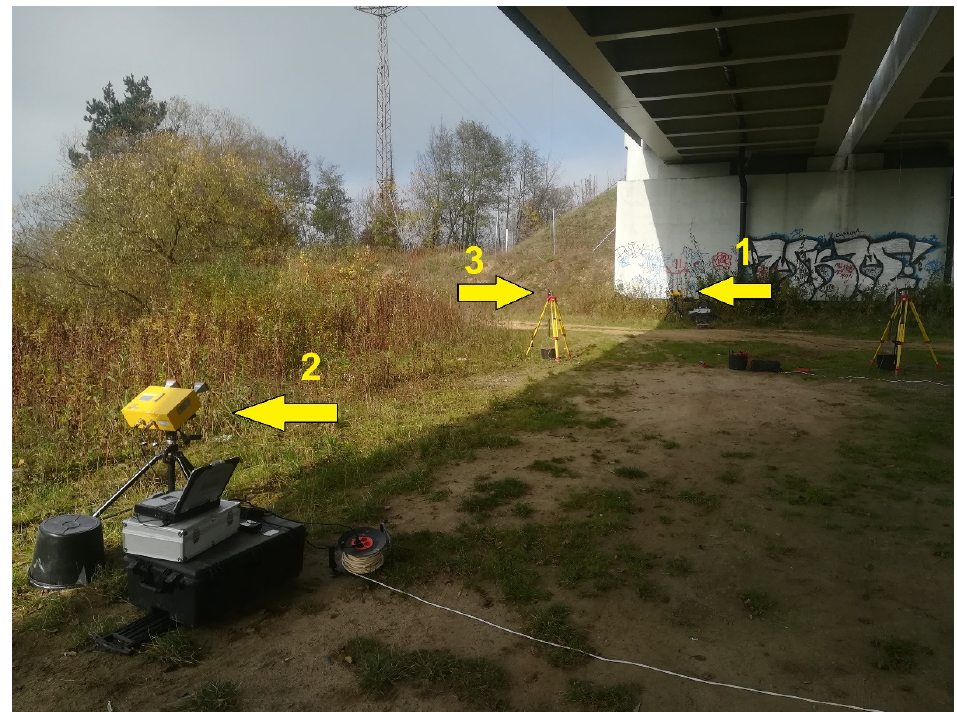
Figure 11. Bridge No. 2; 1—radar No. 1, 2—radar No. 2, 3—inductive transducer for the reference measurement.